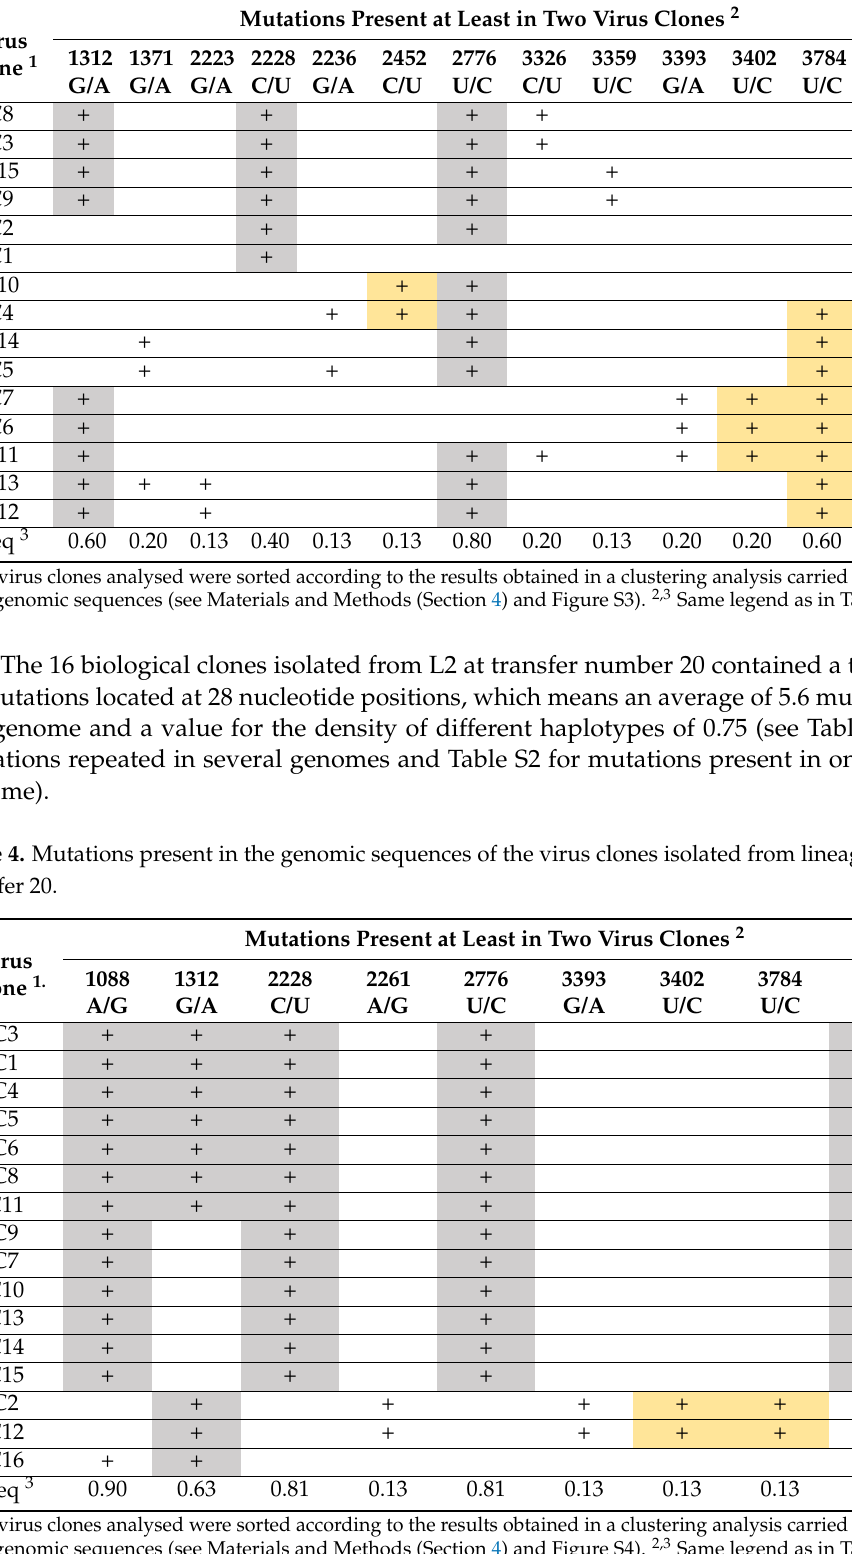
Table 3. Mutations present in the genomic sequences of the virus clones isolated from lineage L2 at transfer 15.